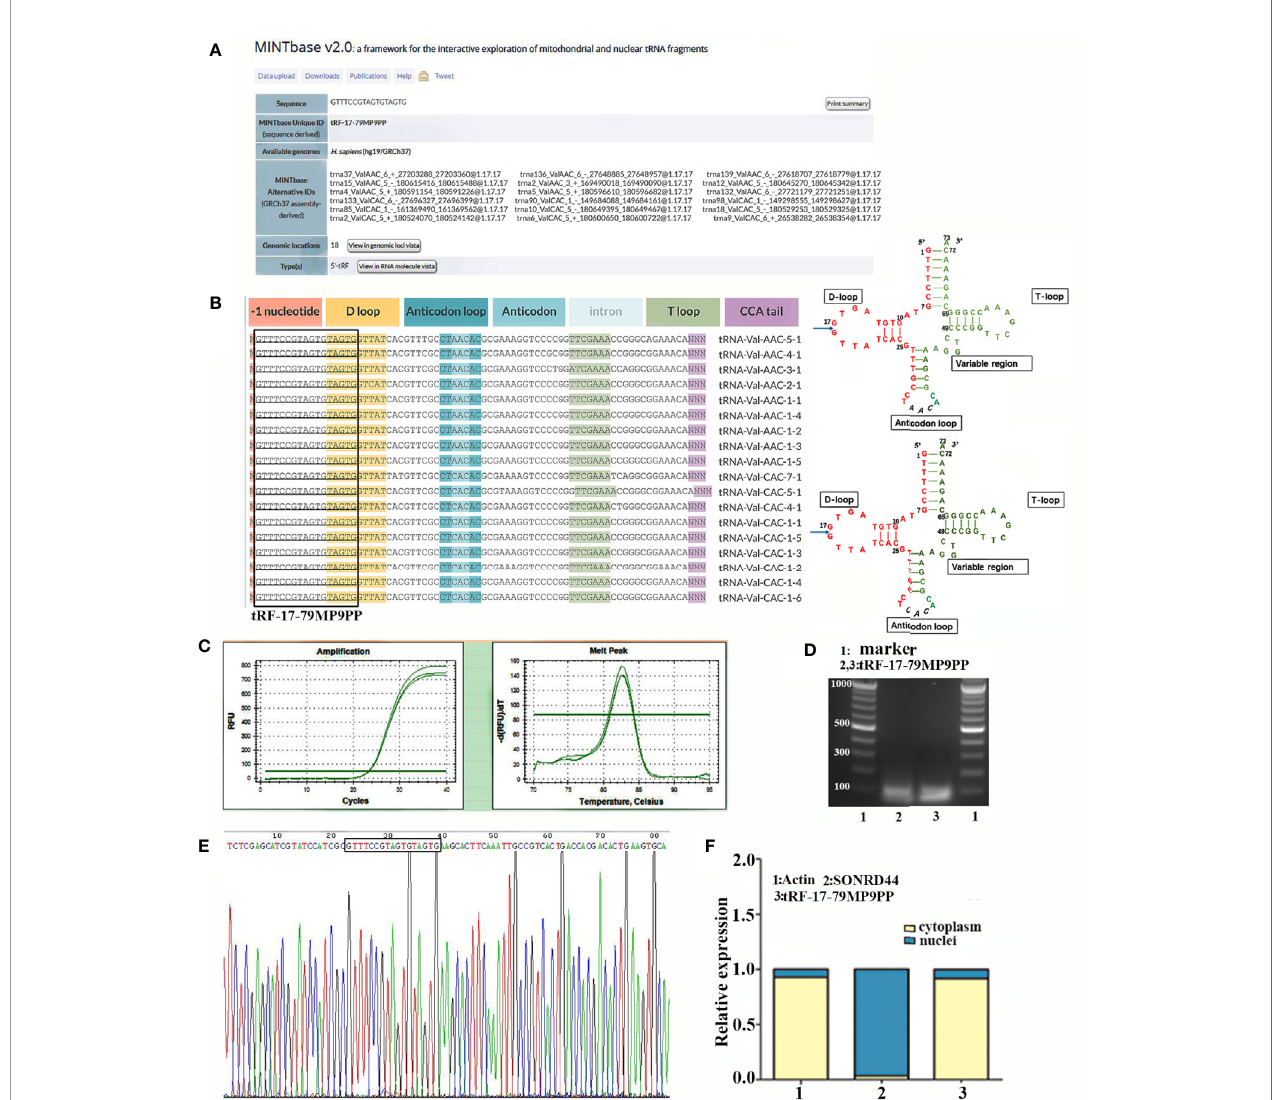
FIGURE 1 | tRF-17-79MP9PP is a type of tRNA-derived fragment. (A) tRF-17-79MP9PP is a 5 ’ - tRF fragment, with 18 genomic locations. (B) tRF-17-79MP9PP was derived from 5 ’ - ends of mature tRNA-Val-AAC and tRNA-Val-CAC with the length of 17nt. The tRF-17-79MP9PP sequences are in the textbox and the arrow points to the cutting position. (C) The dissolution curve and ampli fi cation curve of tRF-17-79MP9PP. (D) The product of RT-PCR was run on 2% agarose gel. (E) The product of qRT-PCR was con fi rmed by Sanger sequencing. (F) Nucleocytoplasmic separation assay revealed that tRF-17-79MP9PP is mainly expressed in the cytoplasm. SONRD44 and actin were used as nuclear and cytoplasm localization markers,